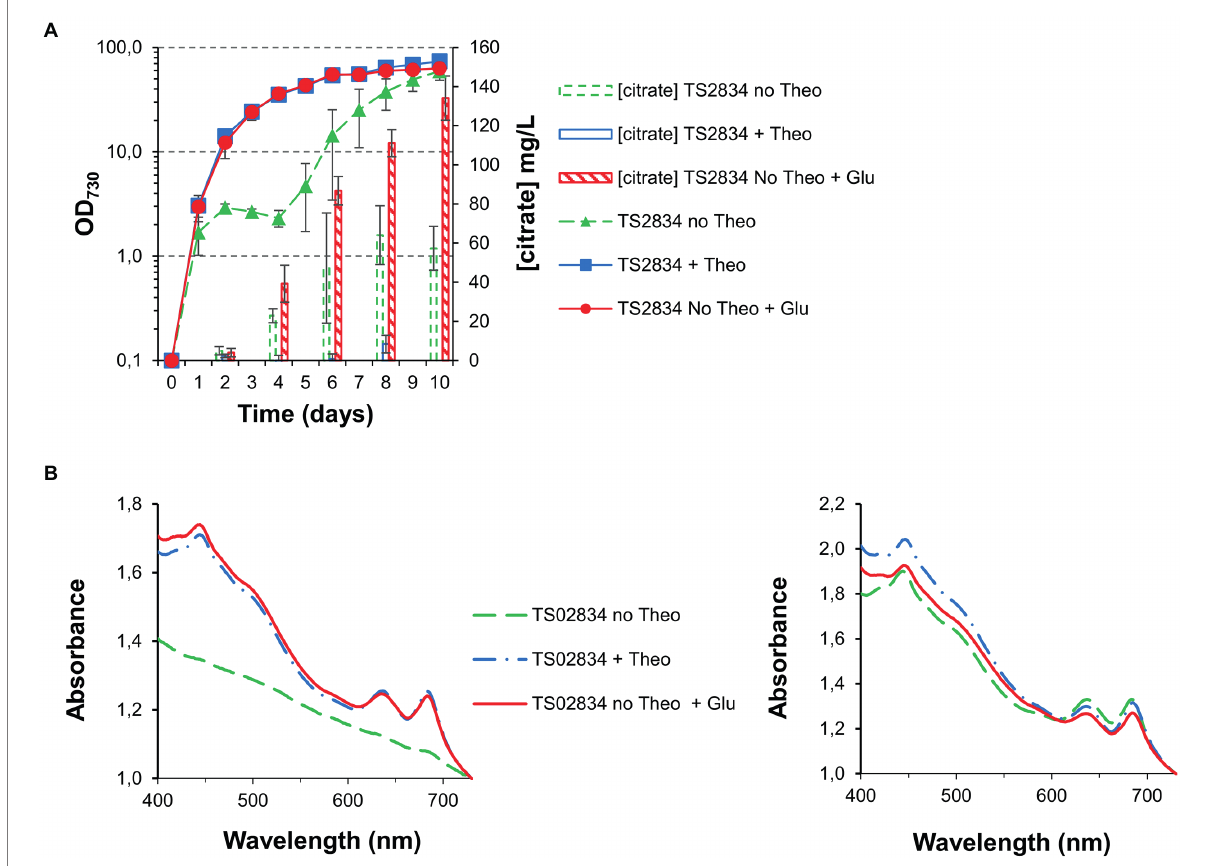
FIGURE 7 Growth curves, citrate quantification and whole cell spectra (in MAD, 1.5% CO 2 , high light) for third generation strains with acnB gene control, without and with glutamate supplementation. (A) Growth curves and citrate quantification. (B) Whole cell spectra at day 3 (left) and day 8